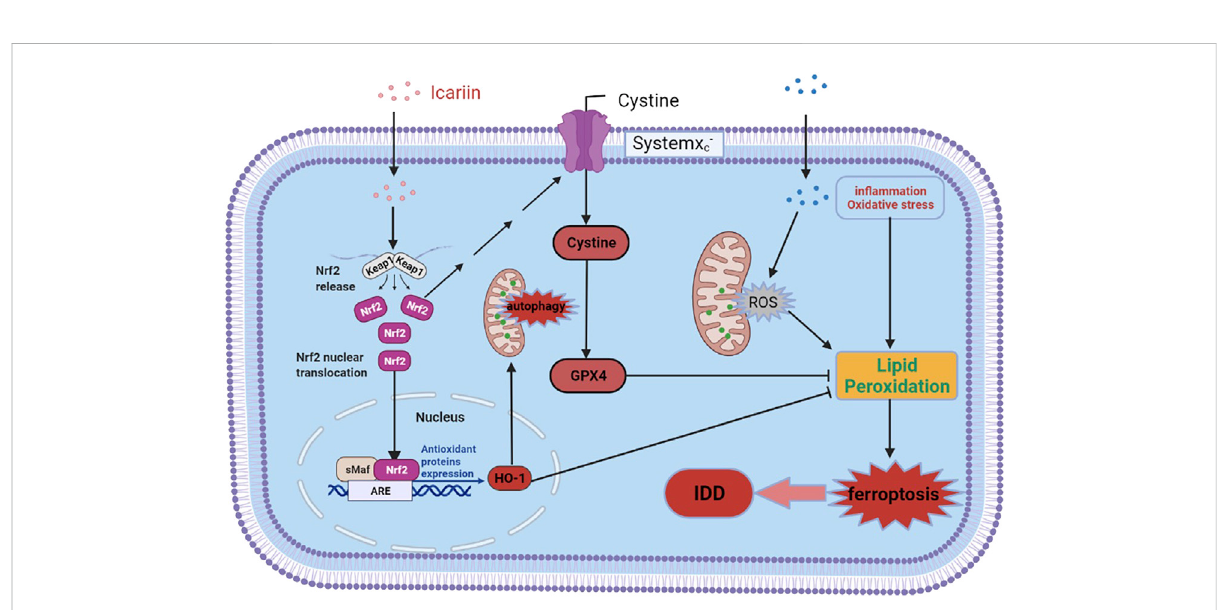
FIGURE 8 SchematicdiagramofICA-mediatedprotectiveeffectsonchondrocytes.ICAsuppressedtheTNF- α andH 2 O 2 -inducedin fl ammation,oxidative stress, and ferroptosis by activating the Nrf2/HO-1 signaling